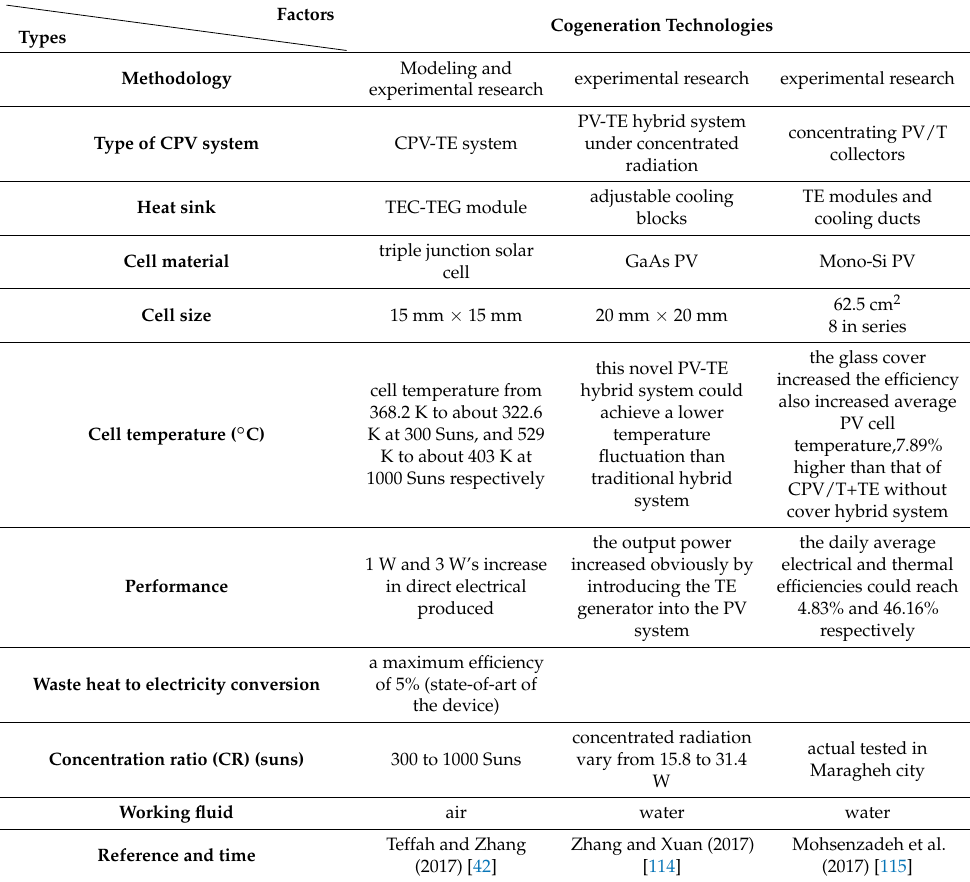
Figure 27. Schematic diagram of the cross-section of CPV/T+TE hybrid collector [115]. Table 6 summaries the cogeneration power technologies mentioned above. Table 6. Summary of the cogeneration power